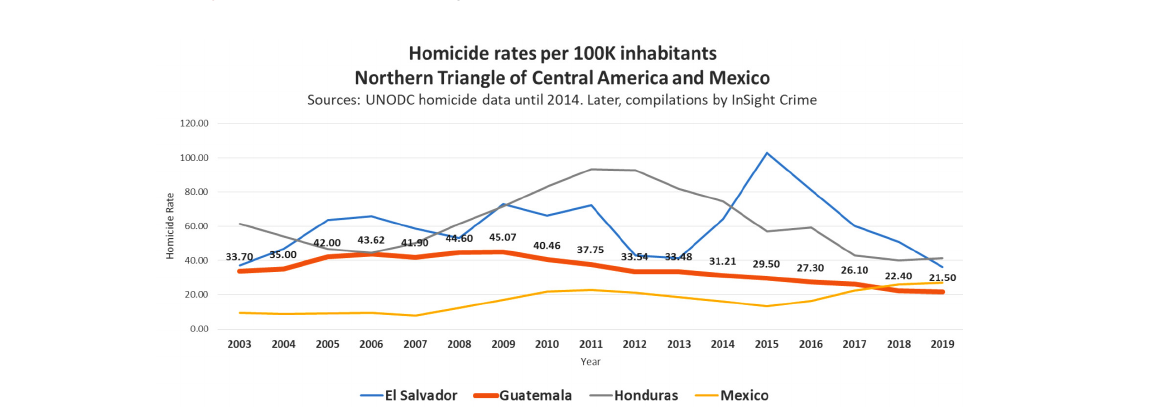
Figure 2. Homicide rates per 100K inhabitants Nothern Triangle of Central America and Mexico.